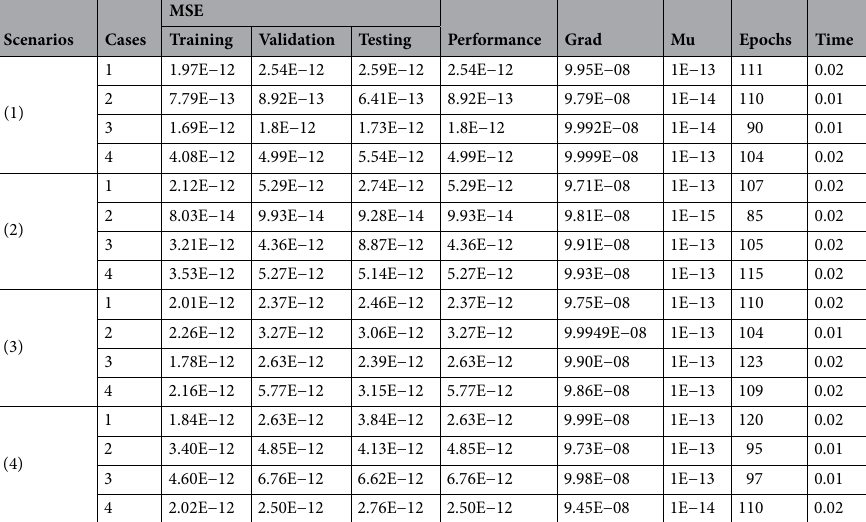
Table 4. Total numerical analysis of LMA-TNN for constant viscosity.